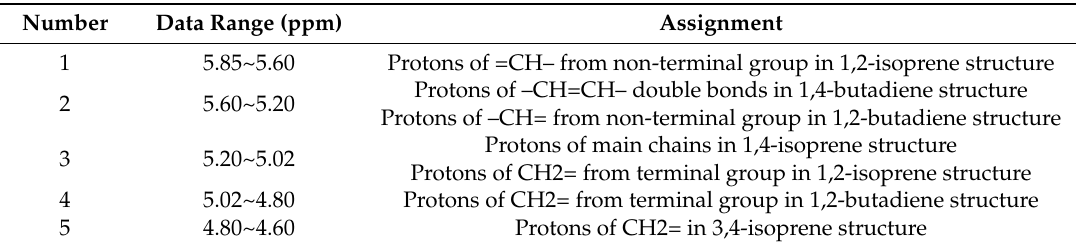
Table 4. Representative peaks and corresponding peak assignment of the butadiene-isoprene copolymer.